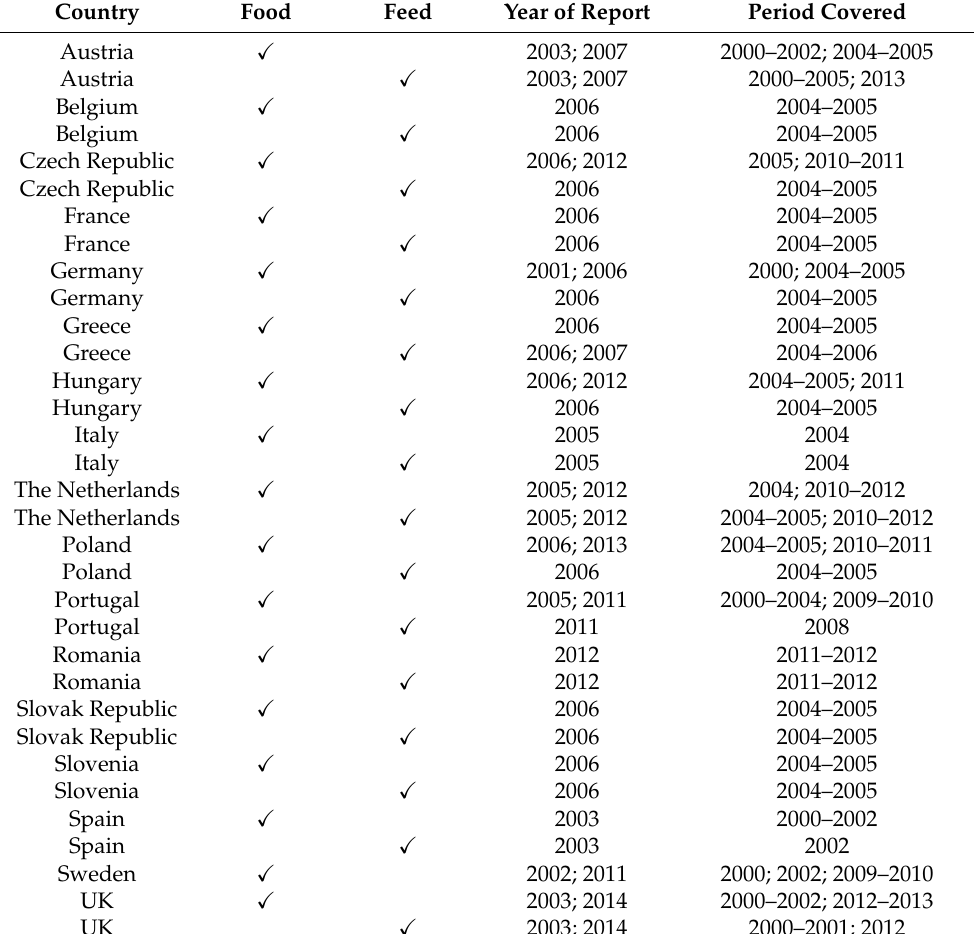
Table 1. Country reports by year, period covered and crop use. Country